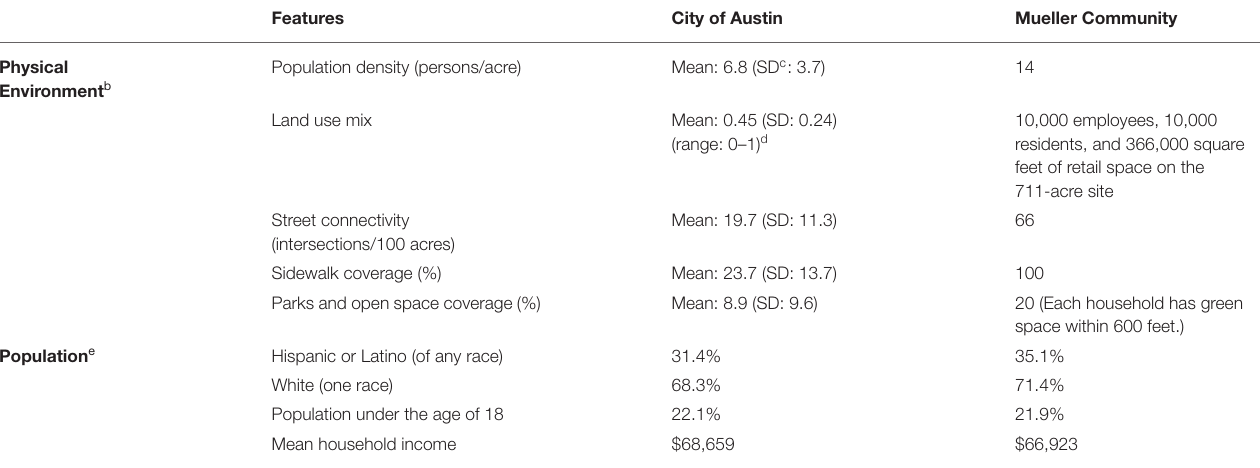
TABLE 1 | Physical environment and population characteristics of the activity-friendly community (AFC) (Mueller community) and City of Austin (71) a at the time of the pilot study